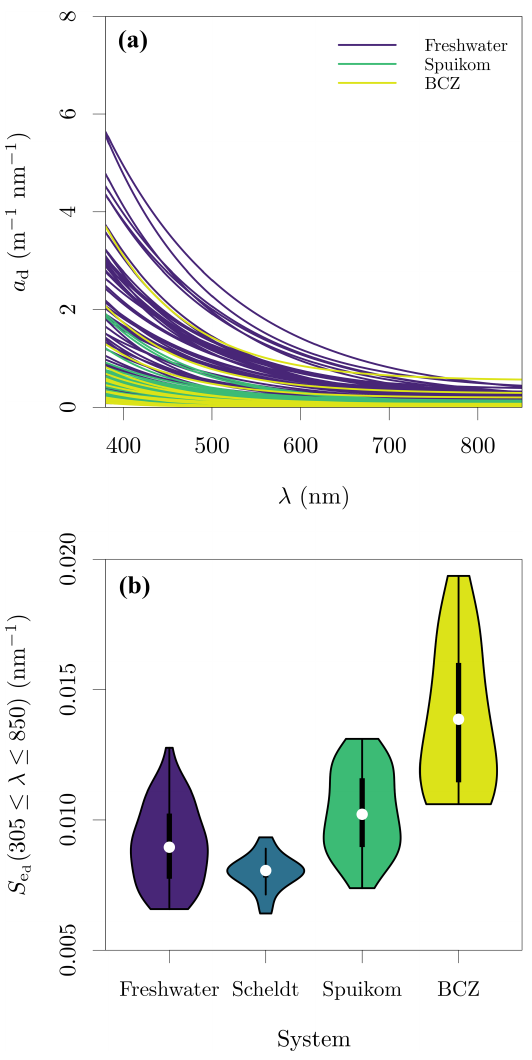
Figure 4. Particle and in vivo pigment absorption in the Belgian Figure 3. Depigmented particle absorption in the Belgian water water systems. (a) Particle absorption coefficient, a p ; and (b) in vivo systems. (a) Fitted depigmented particle absorption coefficient, a d ; pigment absorption coefficient, a (cid:56) . The a (cid:56) presented here was cal- and (b) spectral exponential slope of a d , S e , fitted in the range of d culated with the fitted a d 380 to 850nm. Note that for the Scheldt samples, the exponential model was fitted directly to a p .